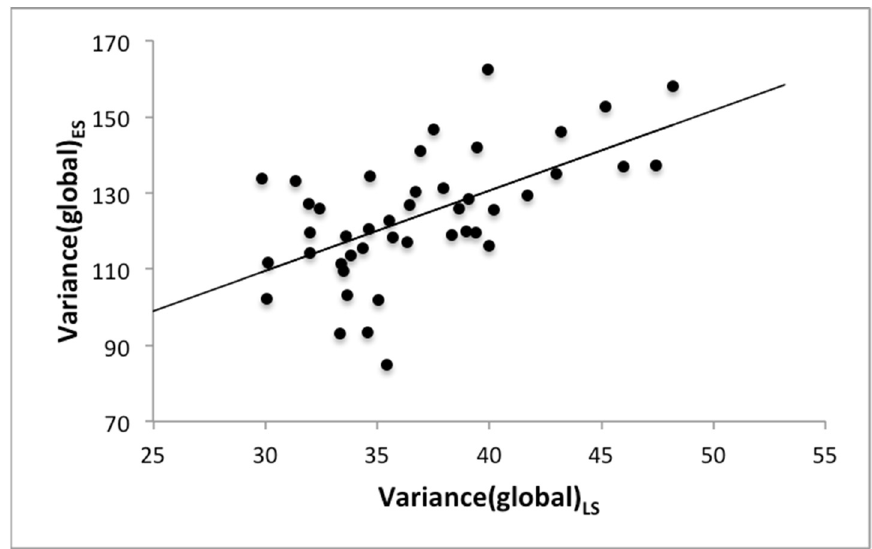
Figure 2. Scatter plot of the measurements of the texture feature Variance(global) for the lumbar spine (LS) and the erector spinae muscle (ES). spine (LS) and the erector spinae muscle